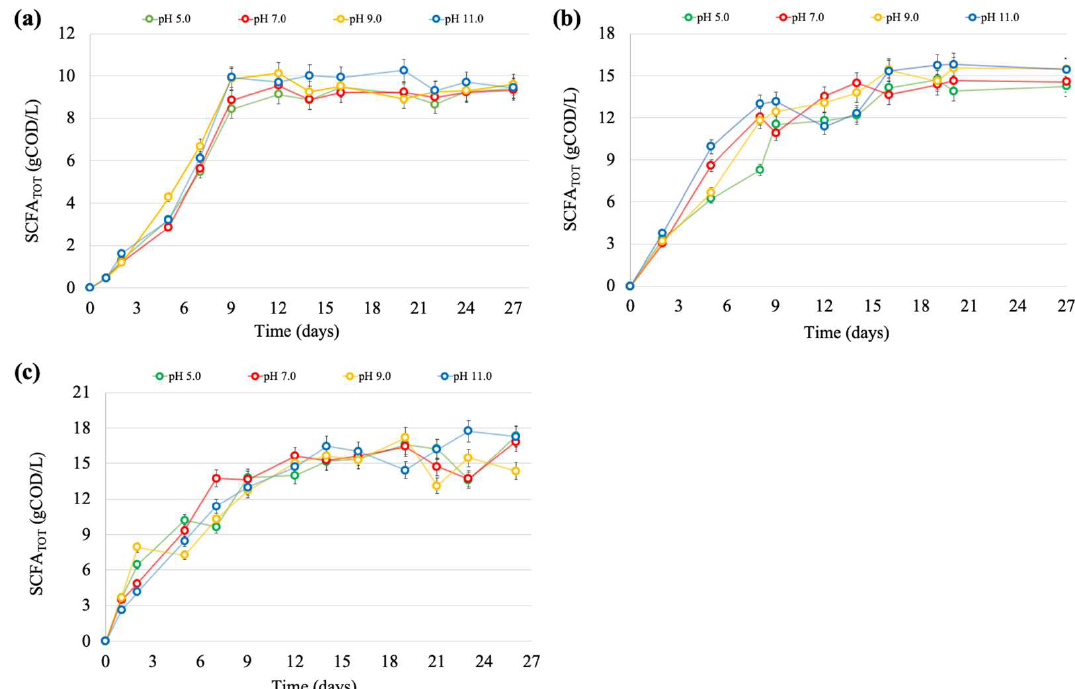
Figure 1. SCFA concentration trends (g COD/L) in the mesophilic batch test M8 ( a ); mesophilic batch test M12 ( b ); mesophilic batch test M8-P ( c ). All three series under the initial pH of 5.0, 7.0, 9.0, and 11.0.